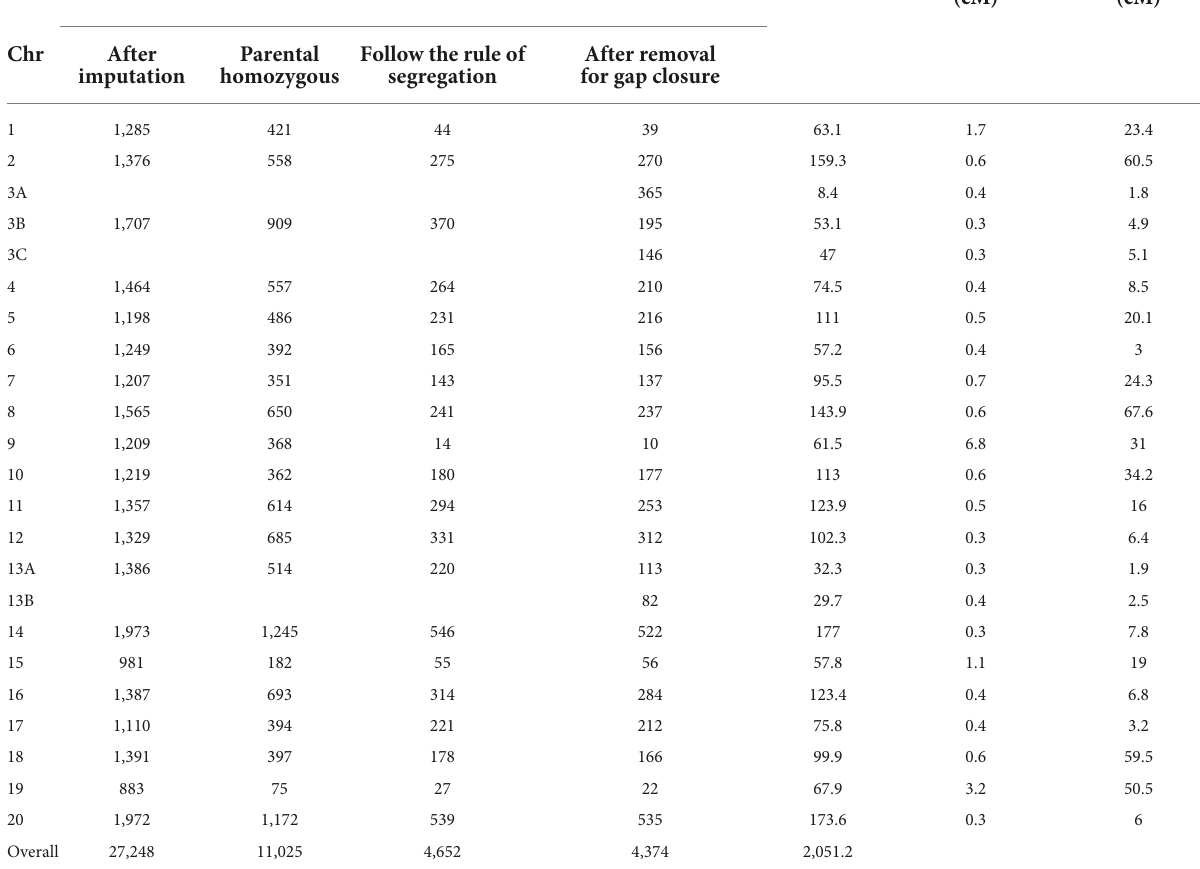
TABLE 1 Genetic map distribution of GSB markers for the ‘Osage’ × PI 593983 RIL